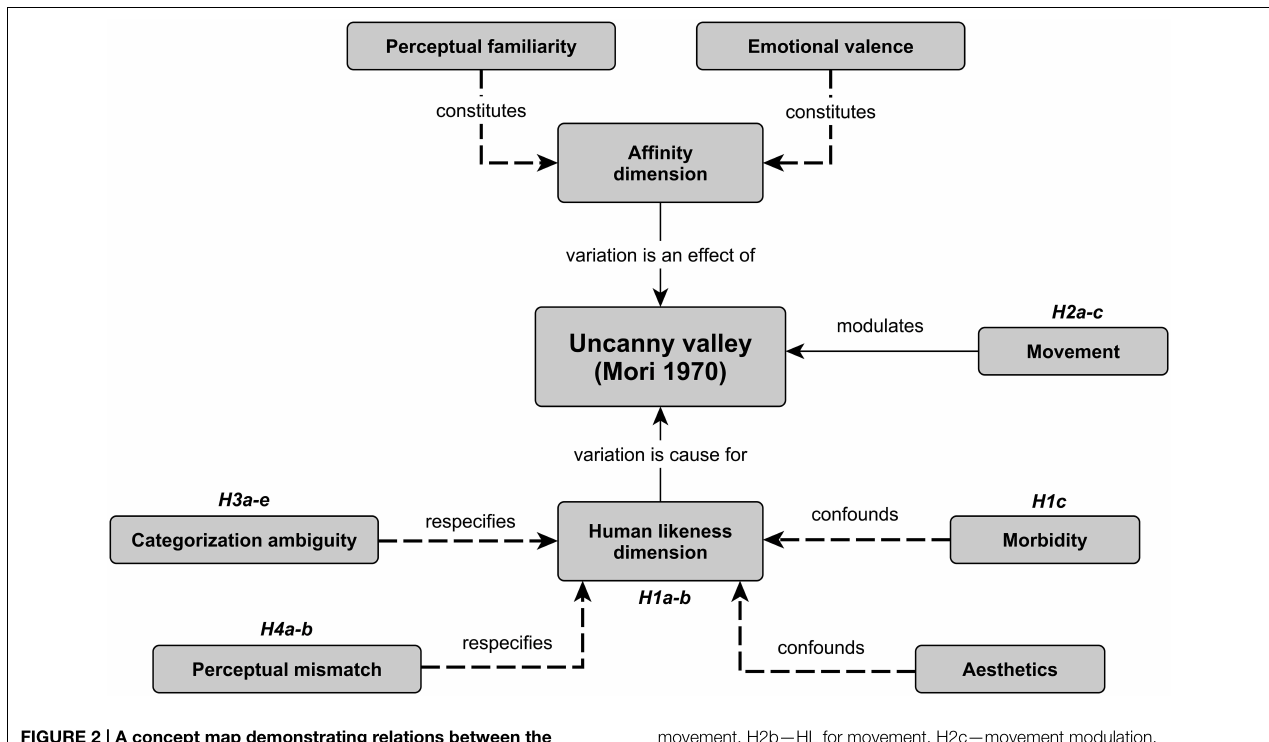
FIGURE 2 | A concept map demonstrating relations between the present uncanny valley hypotheses and different uncanny valley concepts derived from Mori (1970). Dashed lines refer to constructs that have been explicated after Mori’s original publication. Hypotheses: